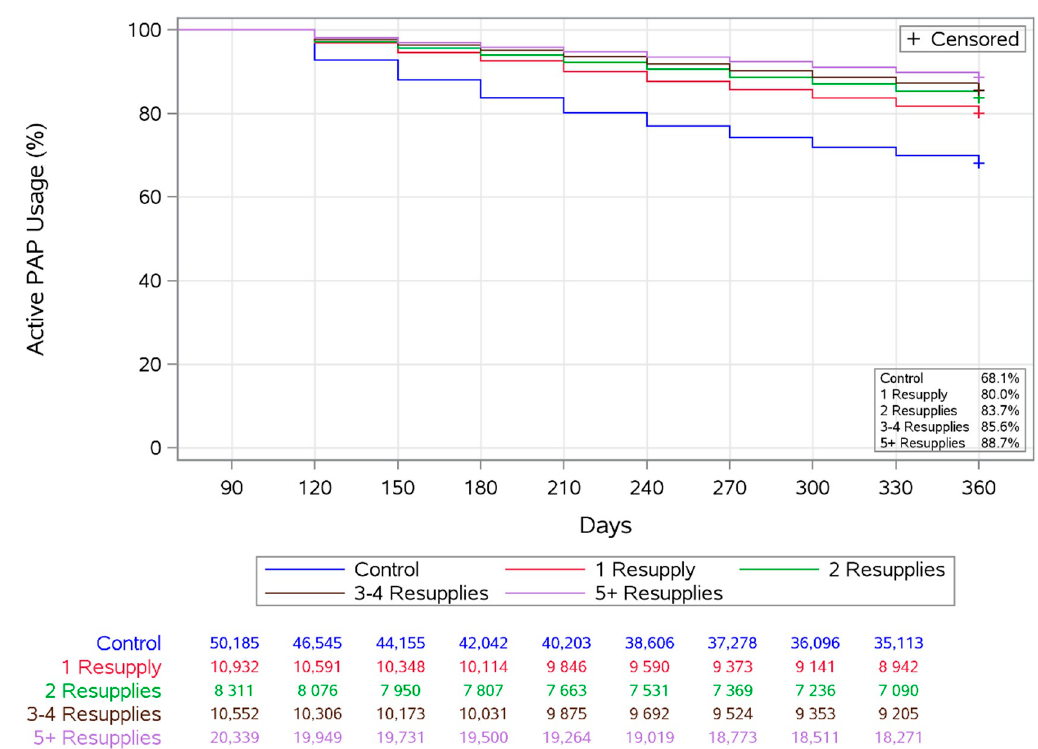
Figure 3. Probability of continuing with the positive airway pressure (PAP) therapy (“survival” of therapy) from days 91–360 in the control and resupply groups broken down by the number of resupplies shipped (primary analysis population). +Censored, patients whose therapy continued after 360 days were censored at the 360 day time